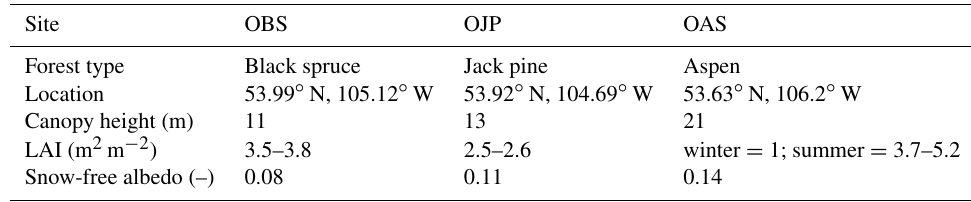
Table 1. Main physical characteristics of the sites.